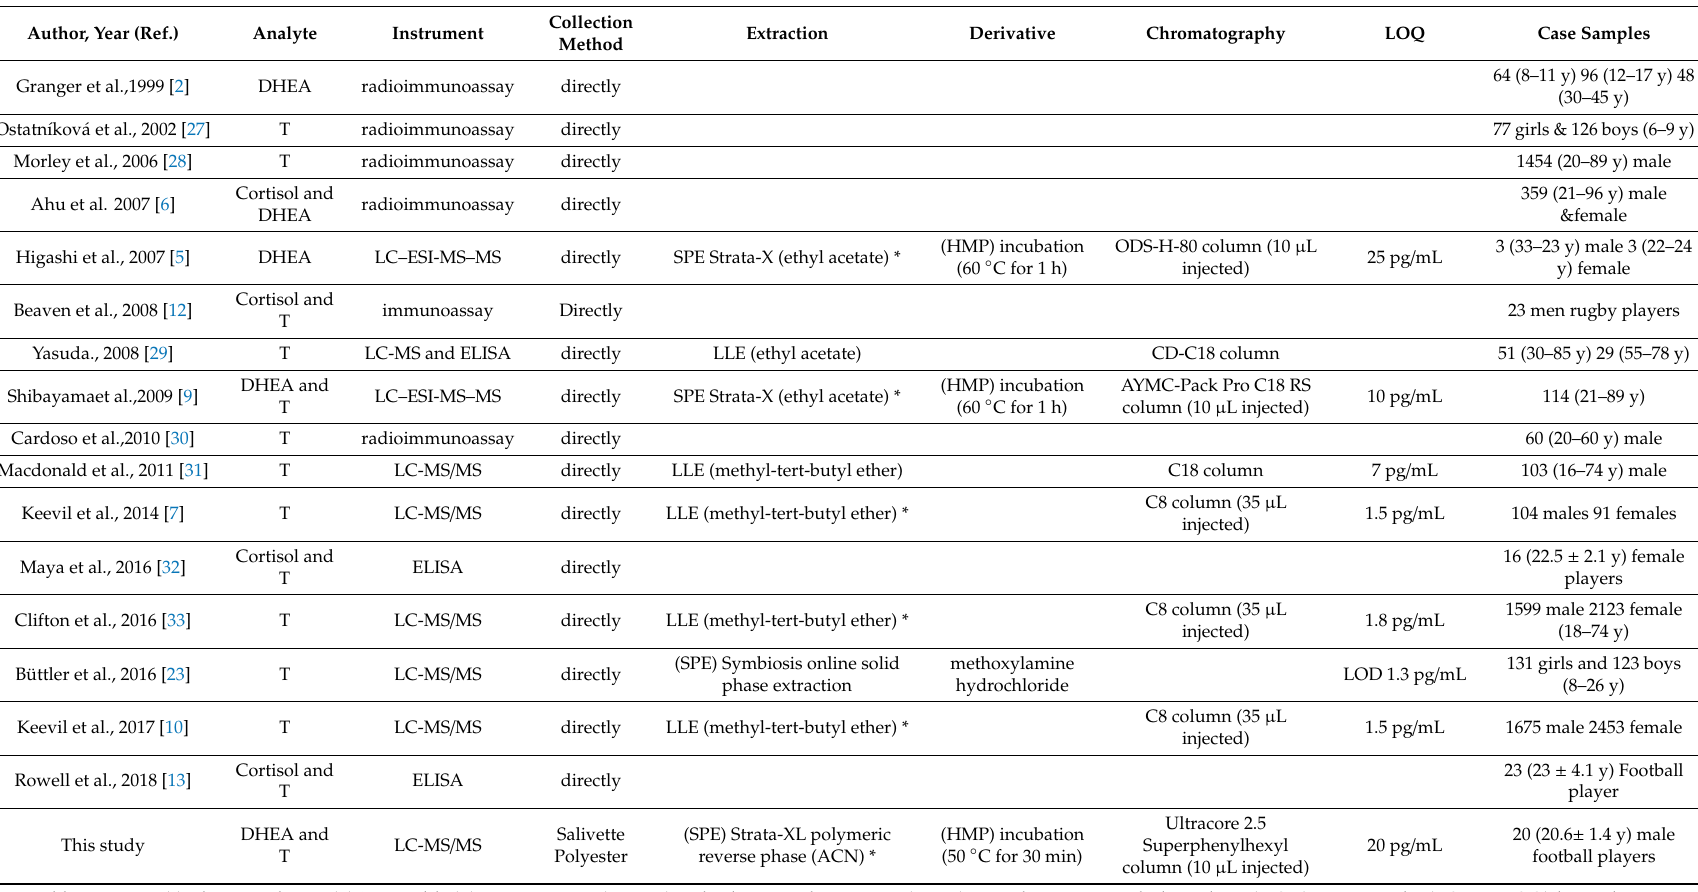
Table 1. Comparison of the present method with previously reported methods of detection of T and DHEA in the saliva